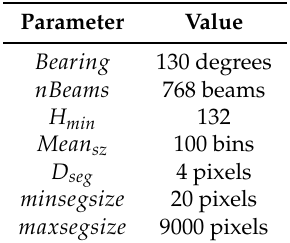
Table 2. Segmentation parameters.